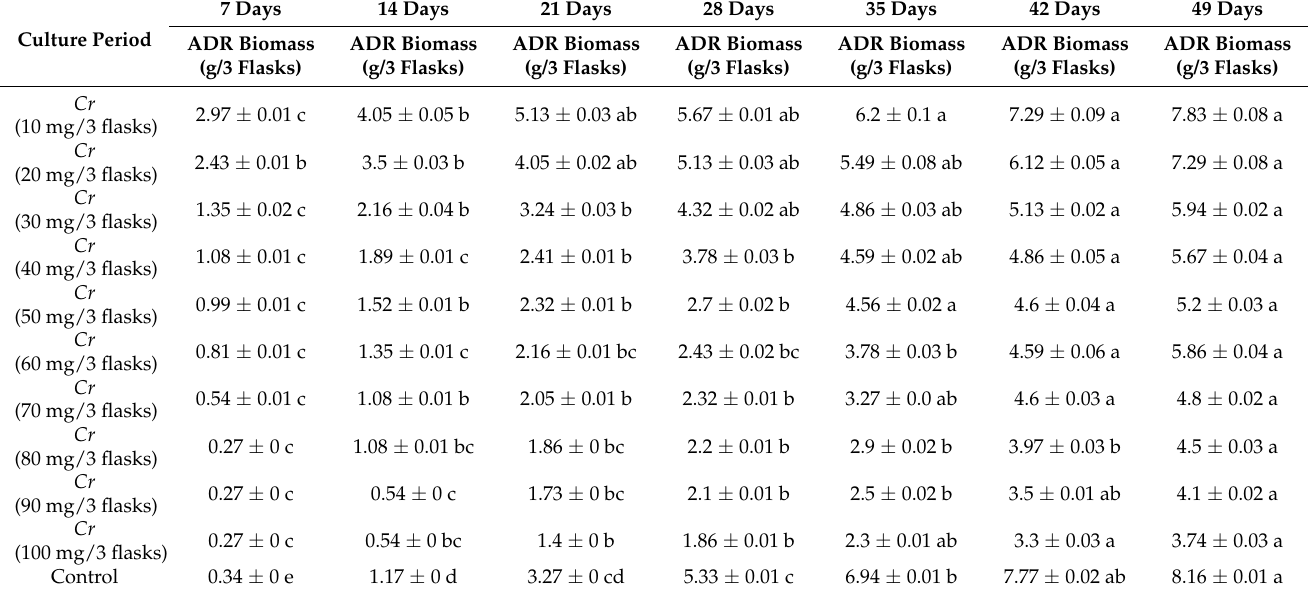
Table 1. Effect of different Cuscuta reflexa ( Cr ) extracts on the growth kinetics of adventitious roots biomass (ADR) of Stevia rebaudiana . Data were collected with 7-day intervals for a period of 49 days. Mean values with standard deviation ( ± SD) of the means did not exceed 5%. Mean values for each treatment were obtained from three independent experiments. Mean values with common alphabets are significantly different at p <